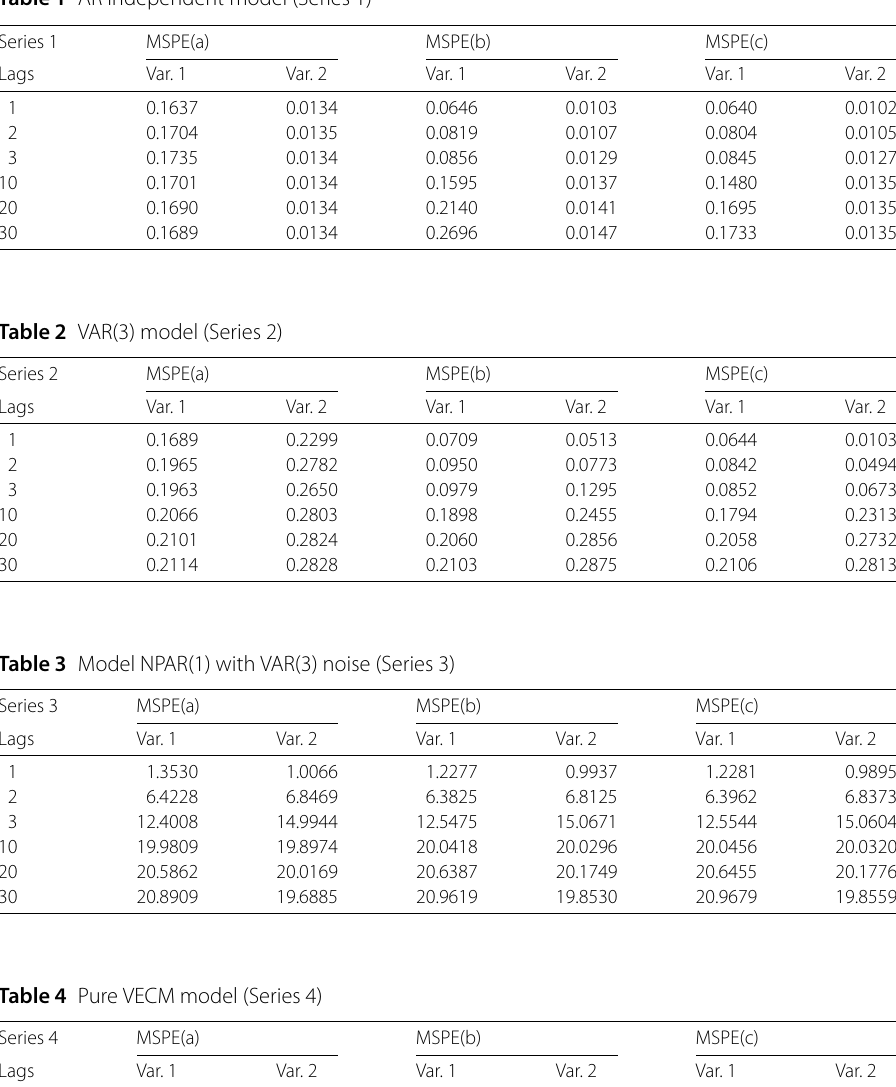
Table 1 AR independent model (Series 1)